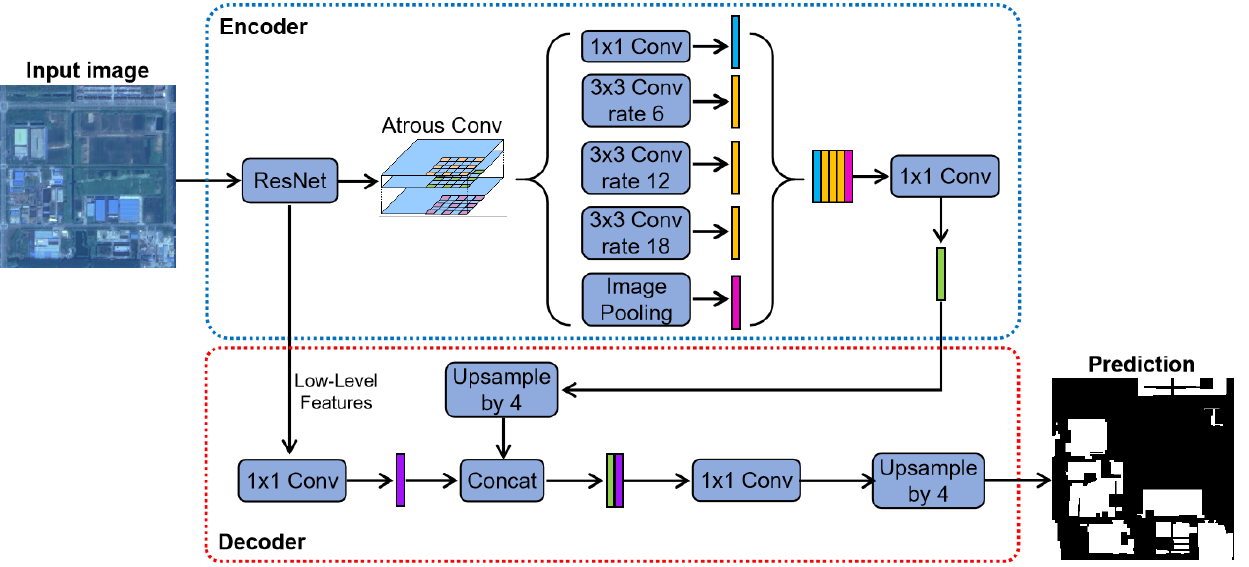
Figure 4. The architecture of the classifier (DeeplabV3+ [7]). The encoder acquires multi-scale features from the images while the decoder provides the predicted results from the multi-scale features and low-level